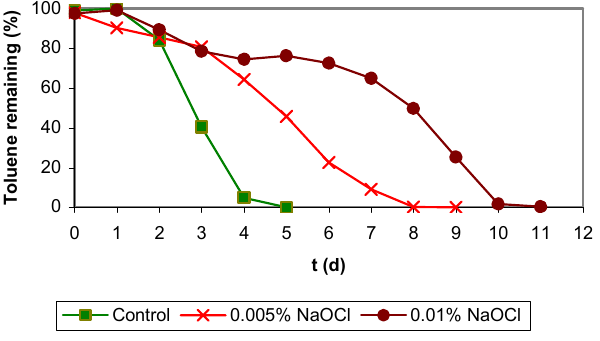
Figure 7. Batch assays with NaOCl and toluene (11 µL volume